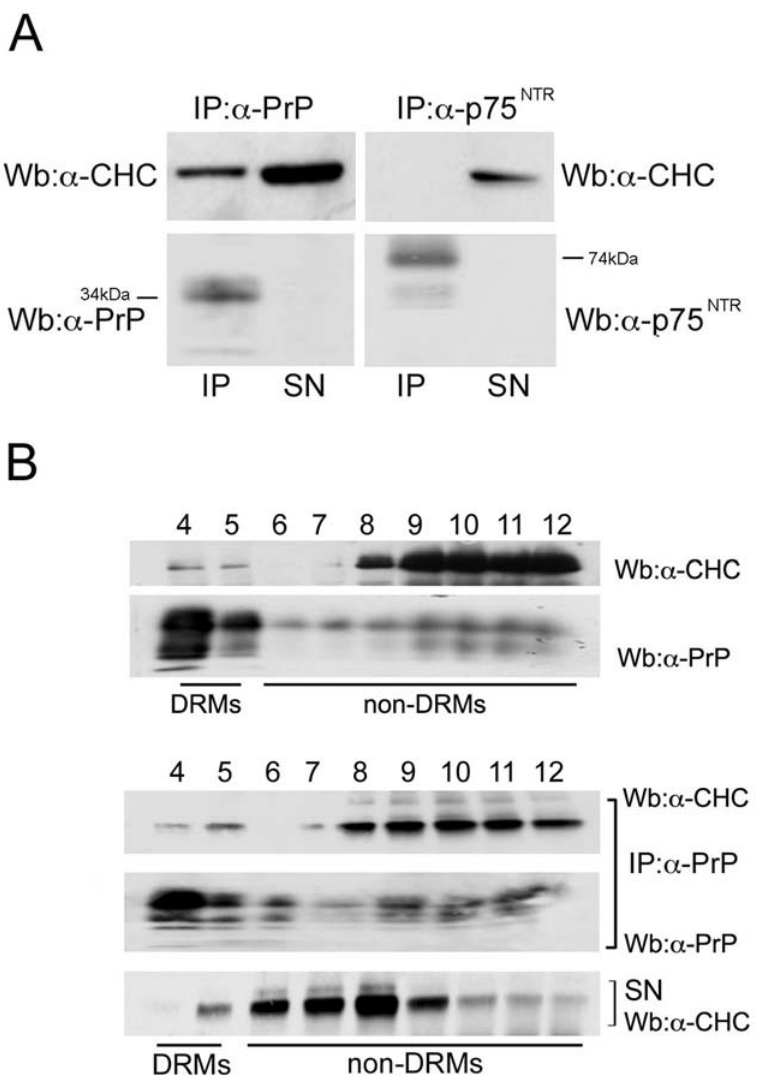
Figure 6. PrP C and clathrin co-immunoprecipitate both in DRM and non-DRM fractions. A) FRT-PrP C cells grown on filters were lysed, immunoprecipitated (IP) by a PrP antibody (SAF32) or a p75 NTR antibody (as negative control), and revealed using: a CHC (TD.1) or a PrP and a p75 NTR antibody as indicated. The supernatants (SN) of the immunoprecipitates were tested by western blot to verify the efficiency of the coimmunoprecipitation. B) Filter grown FRT-PrP C cells were lysed and run on OptiPrep TM gradient to separate DRM from non-DRM fractions. The relative distribution of CHC and PrP C in the fractions (upper panel) was tested by western blot of an aliquot of gradient fractions with specific antibodies. The remaining amount of each fraction (bottom panel) was immunoprecipitated with a PrP antibody SAF32 and revealed by a CHC TD.1 antibody. Supernatants (SN) of the immunoprecipitation (IP) are shown in the bottom panel.